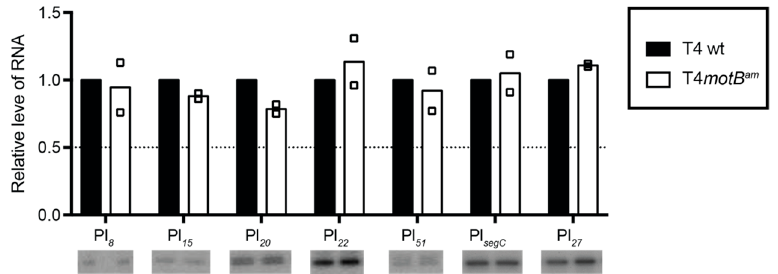
Figure 8. Primer extension products from selected T4 late promoters are similar in T4 wt or a T4 motB am infection at 10 min post-infection. Histograms show the level of primer extension product obtained from the indicated late promoter using RNA from a T4 motB am infection (open bar) or a T4 wt (black bar) infection; representative slices of DNA gels are shown below. Primer extensions were repeated using 2 biological replicates. The relative level of product for each replicate is shown as an open square (T4 motB am ). The dotted line indicates the threshold for a twofold change in the level of RNA.